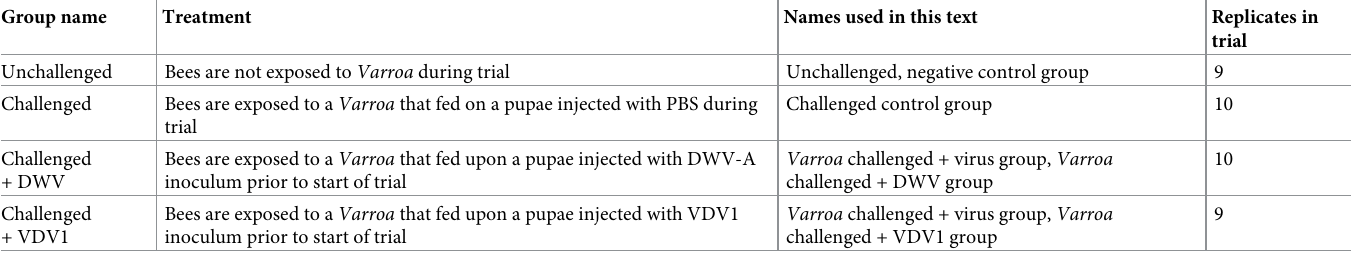
Table 1. Explanation of experimental groups. Groups, description of treatments, naming, and number of replicates in the trial. One replicate was removed from the unchallenged group, and one from the challenged + VDV1. Group